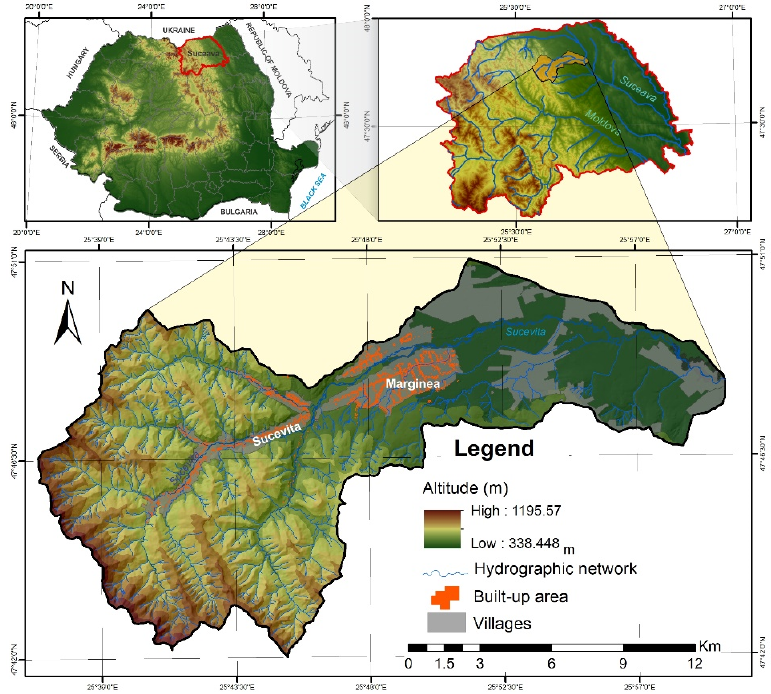
Figure 1. Study area—Sucevi ț a river basin.